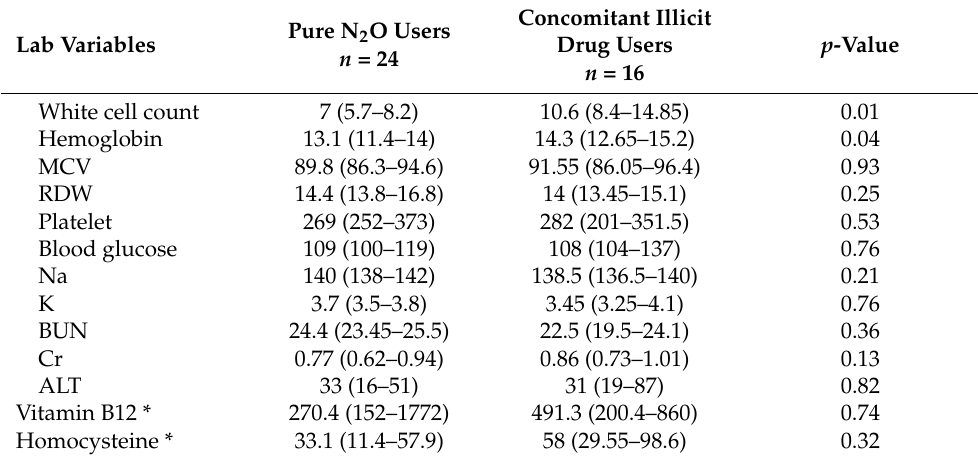
Table 2. Laboratory investigations of ED patients intentionally using N 2